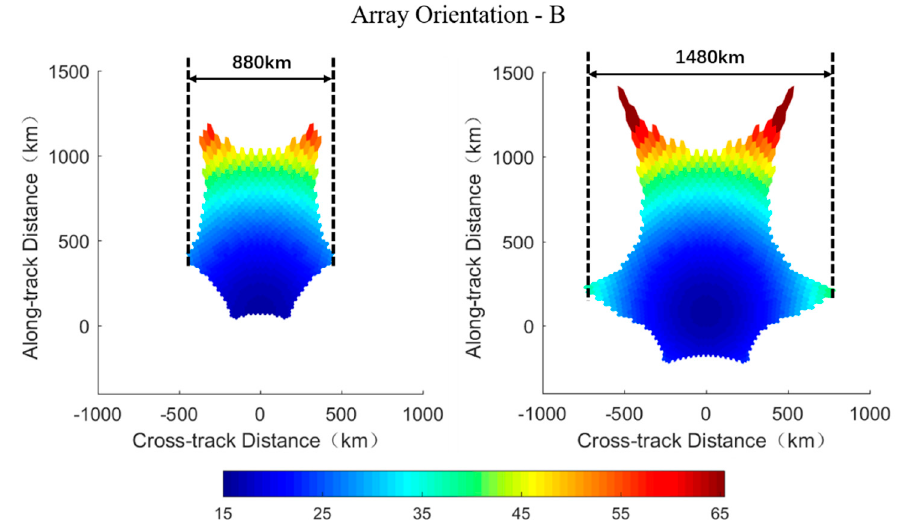
Figure 8. Illustration of the ground spatial resolution distributions of the array orientation B. The distributions in the AF-FOV and EAF-FOV are shown in the left and right panels, respectively, and the corresponding swath widths are labeled in each subplot. The color bar represents the square root of each pixel’s area in km.